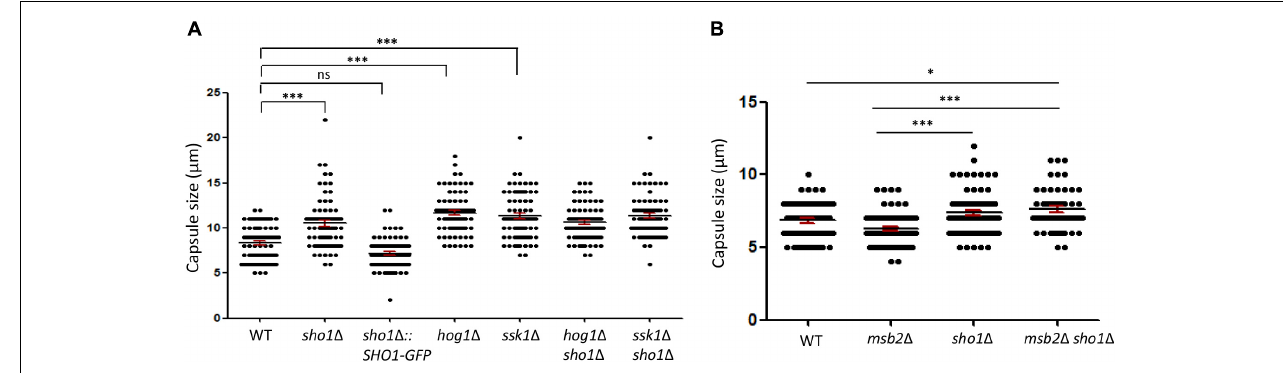
FIGURE 6 | Sho1, but not Msb2, plays a repressive role in the capsule production in C. neoformans . (A,B) The capsule production was observed microscopically. Wild-type (WT; H99), sho1 (cid:49) (YSB1719), sho1 (cid:49) ::SHO1-GFP (YSB2753), hog1 (cid:49) (YSB64), ssk1 (cid:49) (YSB261), hog1 (cid:49) sho1 (cid:49) (YSB2268), ssk1 (cid:49) sho1 (cid:49) (YSB2253), msb2 (cid:49) (YSB3191), and sho1 (cid:49) msb2 (cid:49) (YSB3605) strains were spotted onto Dulbecco modified Eagle medium, incubated for 2 days at 37 ◦ C. Graph of capsule diameter of all the strains. Capsule diameter was determined using the equation [(total diameter) – (cell body diameter)]. The statistical significance is indicated as follows: ns, not-significant; ∗ P < 0.05 and ∗∗∗ P <